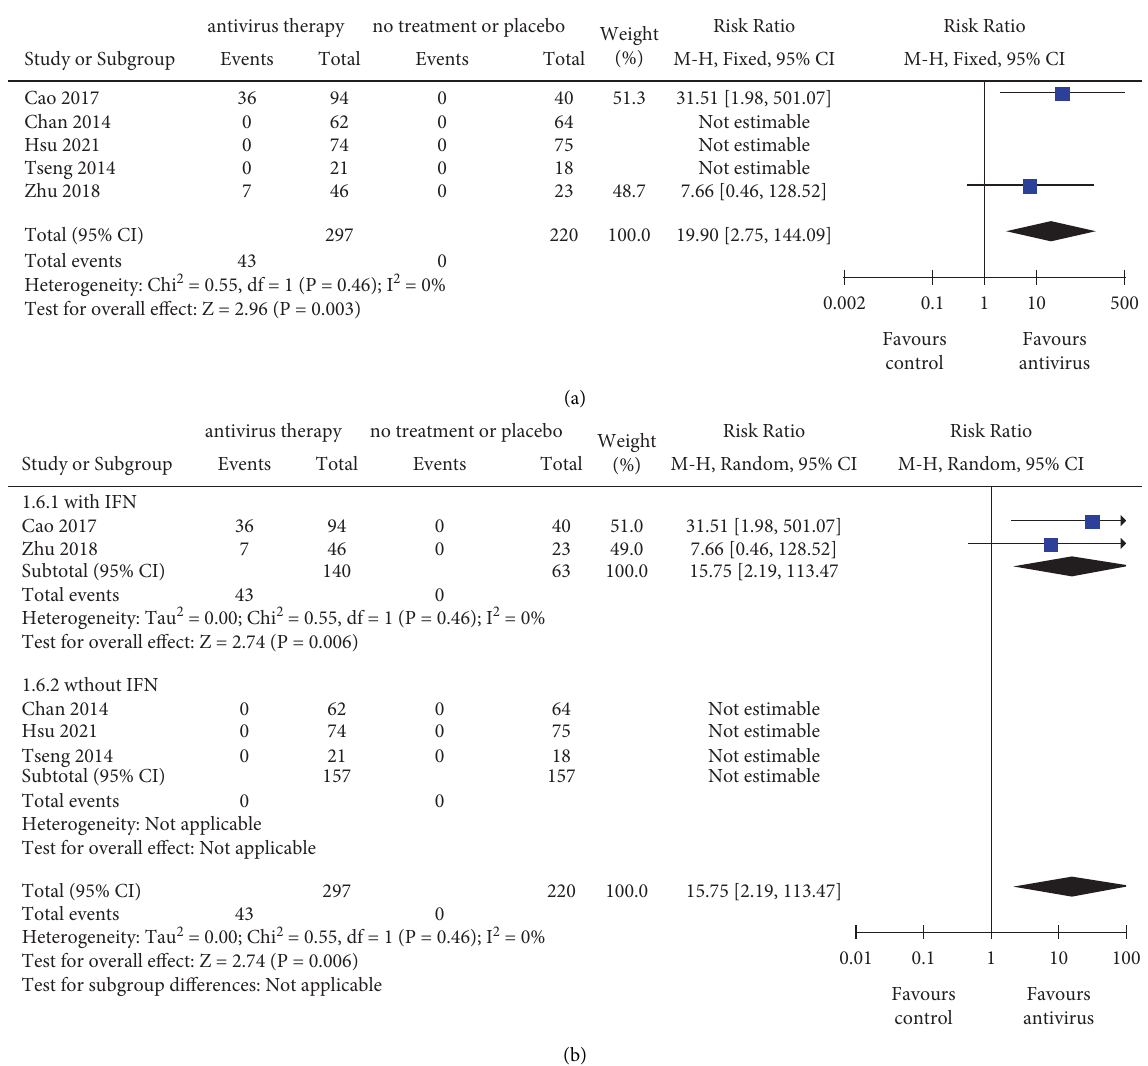
Figure 3: Te outcomes of HBsAg seroconversion. (a) Pooled risk ratio for HBsAg seroconversion between the antiviral therapy group and control group. (b) Subgroup analysis stratifed by therapeutic regimen with or without IFN. IFN, interferon; CI, confdence interval. Te size of square represents the weight of each study, and the vertical dotted line represents the pooled